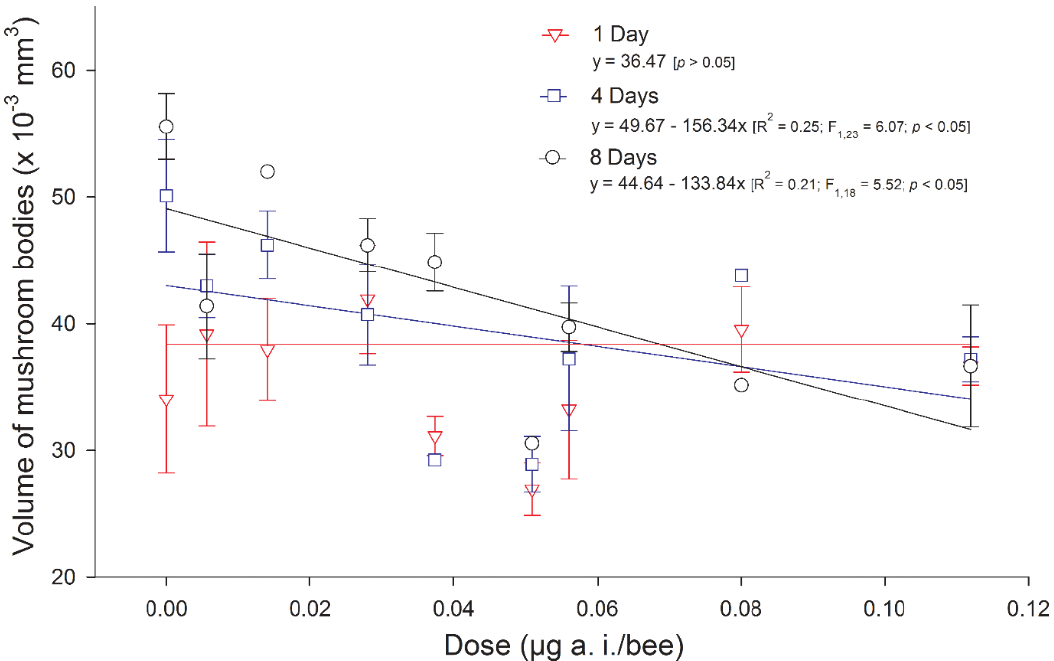
Figure 3. Mean volume of the mushroom bodies in the brains of 1-day-old (triangles), 4-day-old (squares) or 8-day-old (circles) stingless bee workers ( Melipona quadrifasciata anthidioides ) reared on imidacloprid-contaminated diets during the larval period. The vertical bars represent standard errors (reproduced from [66] CC BY).